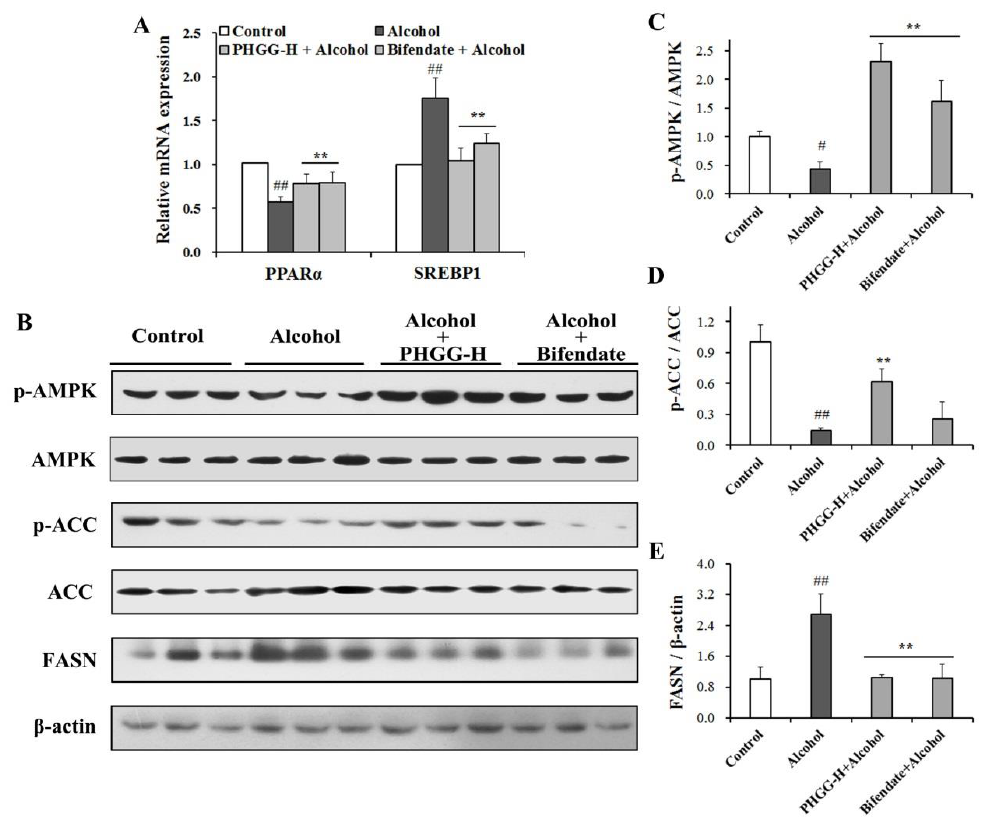
Figure 3. E ff ect of partially hydrolyzed guar gum (PHGG) on alcohol-induced liver damage. ( A ) Gene expressions of PPAR α and SREBP1 in liver tissues were quantified by RT-qPCR analysis. ( B ) Western blot images of p-AMPK, p-ACC, and FASN. Densitometric blots of p-AMPK ( C ), p-ACC ( D ), and FASN ( E ) were produced by measuring protein band density using ImageJ software. Liver tissues were collected from mice of di ff erent treatment groups: control group, alcohol group, PHGG-H + alcohol group, and bifendate + alcohol group. Results are shown as mean ± SD ( n = 3) of three independent experiments. “#” ( p < 0.05) and “##” ( p < 0.01), significantly di ff erent when compared to the control group. “**” ( p < 0.01), significantly different when compared to the alcohol group. PHGG-H + Alcohol: